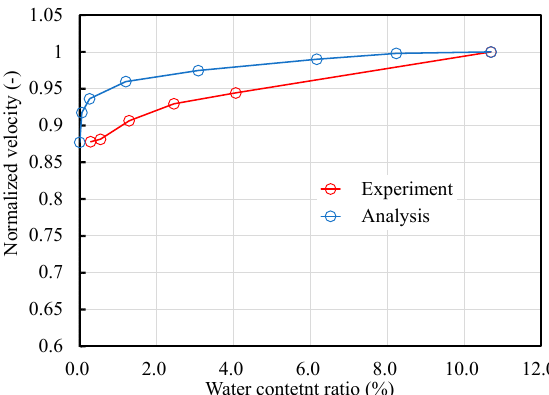
Figure 12. Relationship between the moisture content ratio and normalized amplitude.